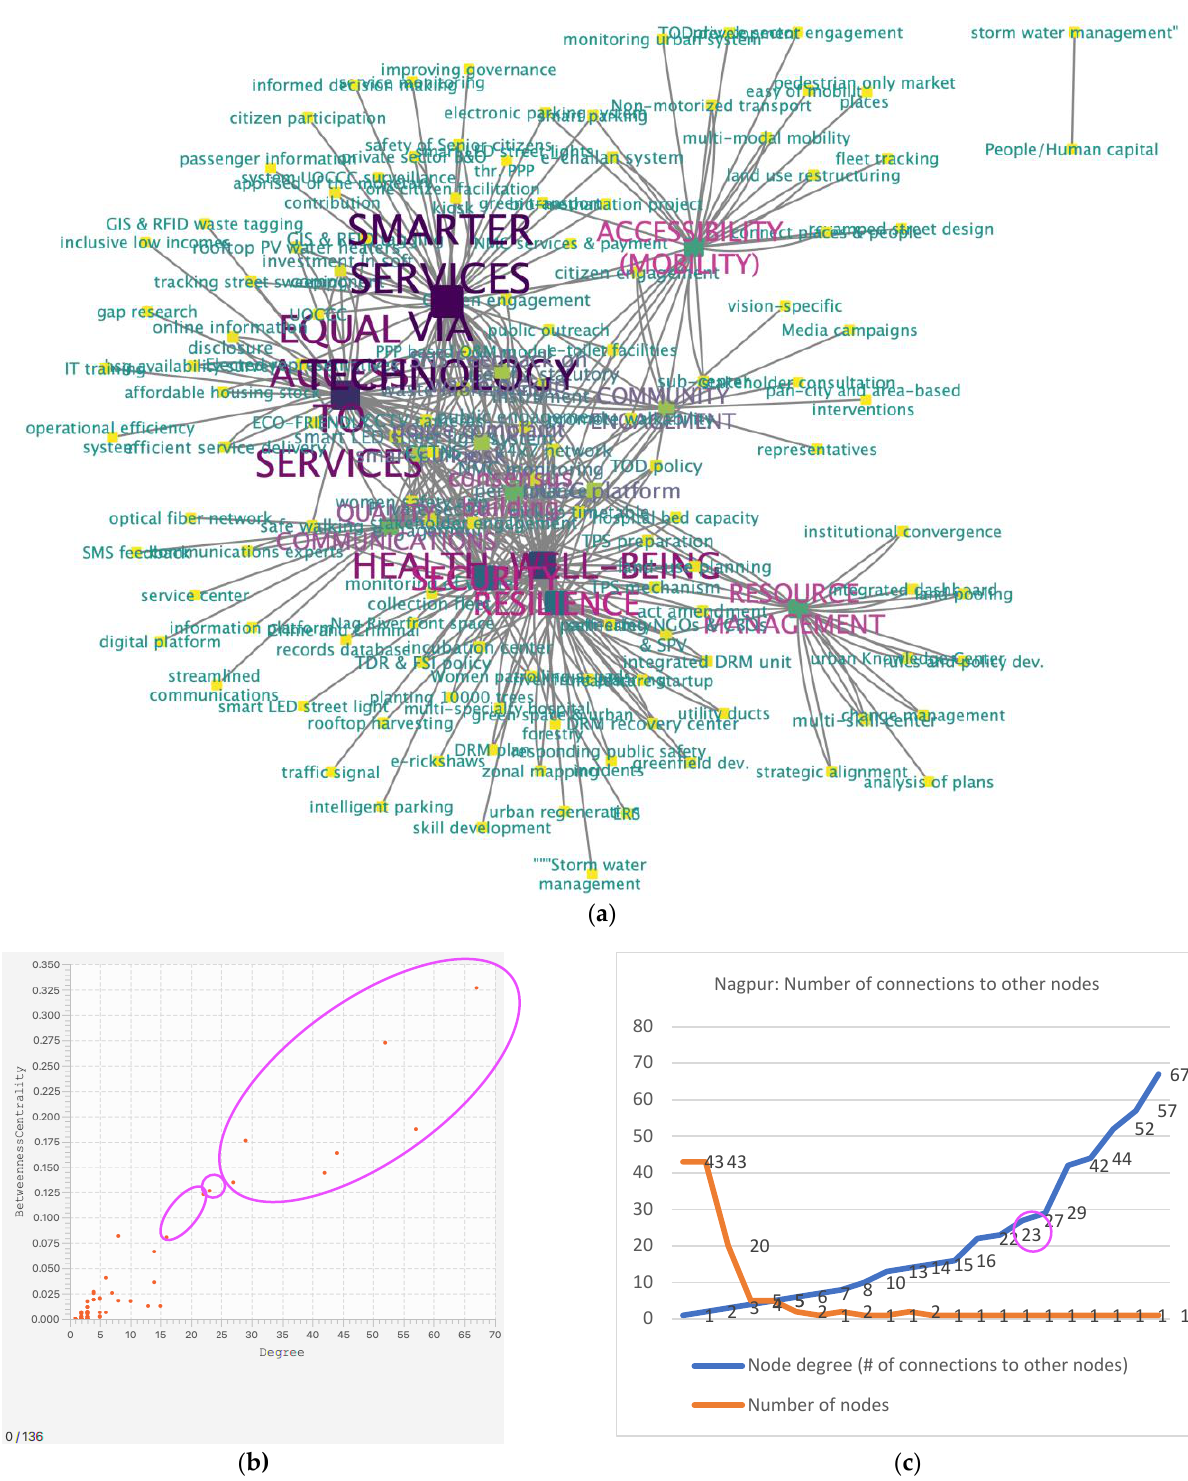
Figure 3. ( a ): Nagpur — soft asset value elements, soft asset capitals, and activities/initiative (image